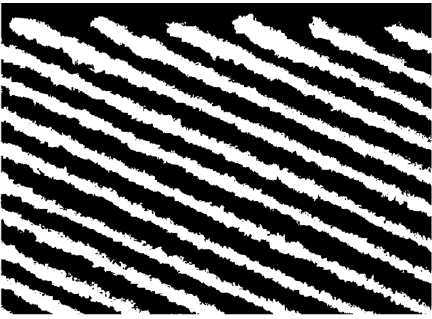
Figure 9. Representation of binarized vineyard rows by applying the Otsu method.